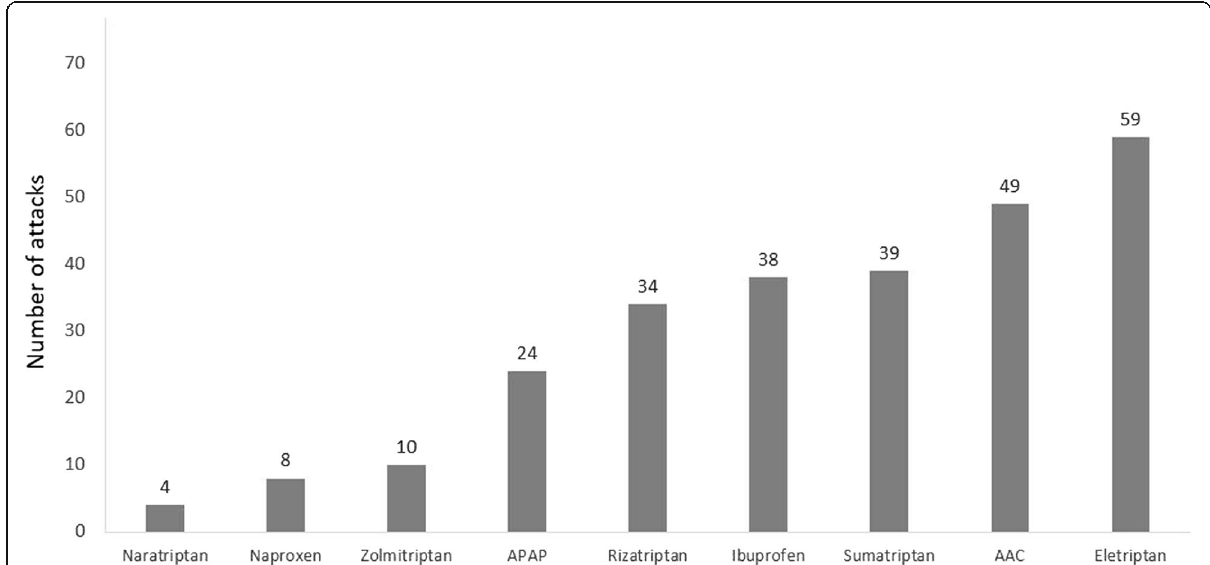
Fig. 1 Number of participants using different types of acute pharmacological treatments in their first reported attack in the run-in phase. AAC, aspirin, acetaminophen and caffeine; APAP,